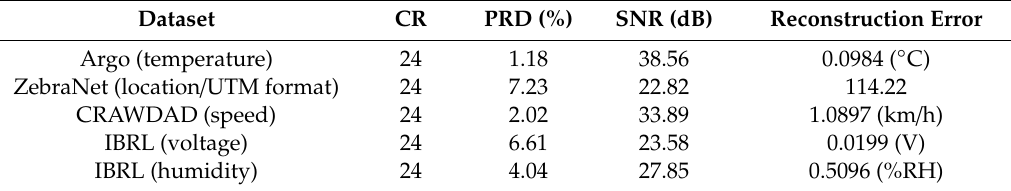
Table 3. Model performance on di ff erent